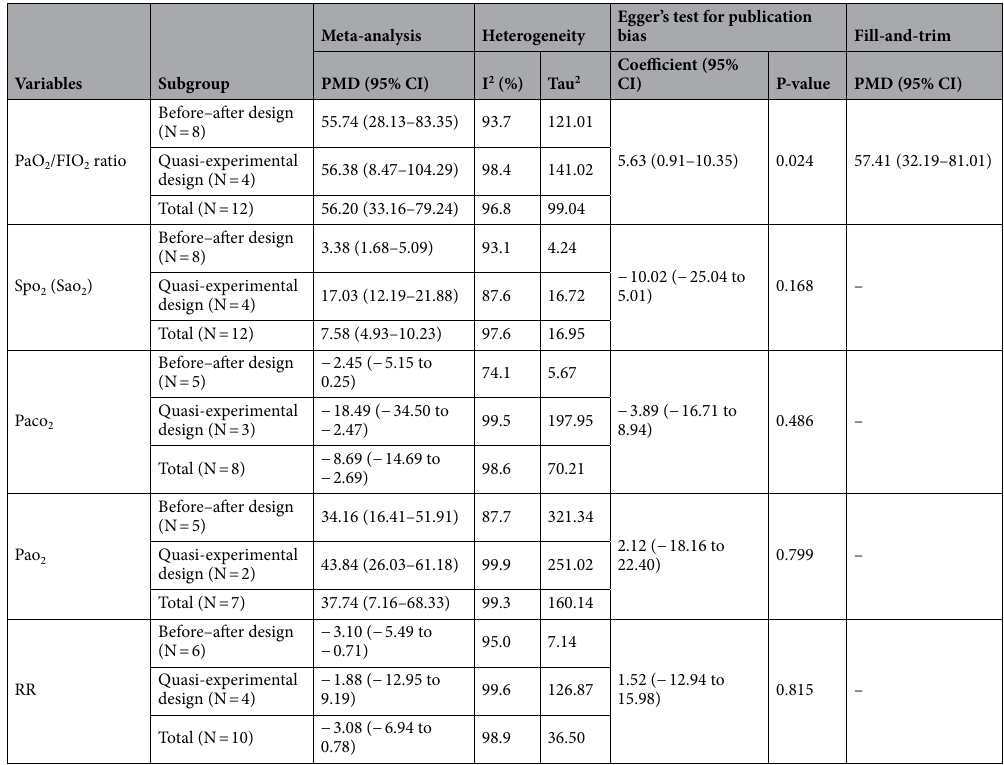
Table 3. Result of meta-analysis for calculation of pooled mean difference of respiratory parameters; publication bias and fill and trim method. CI confidence interval, N number of study, PMD pooled